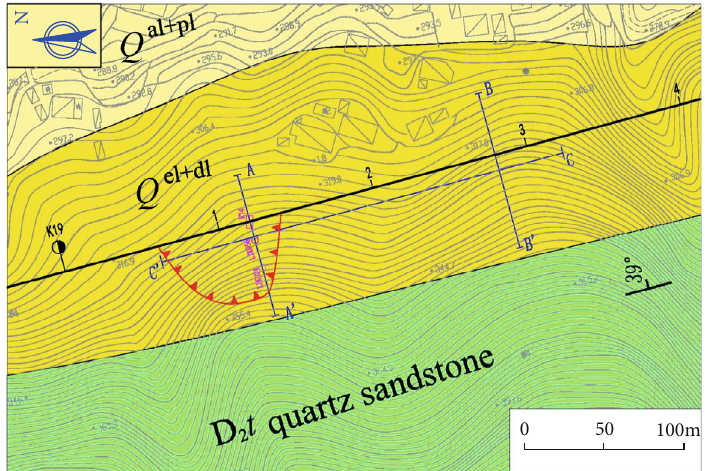
Figure 1: Geological engineering plane.